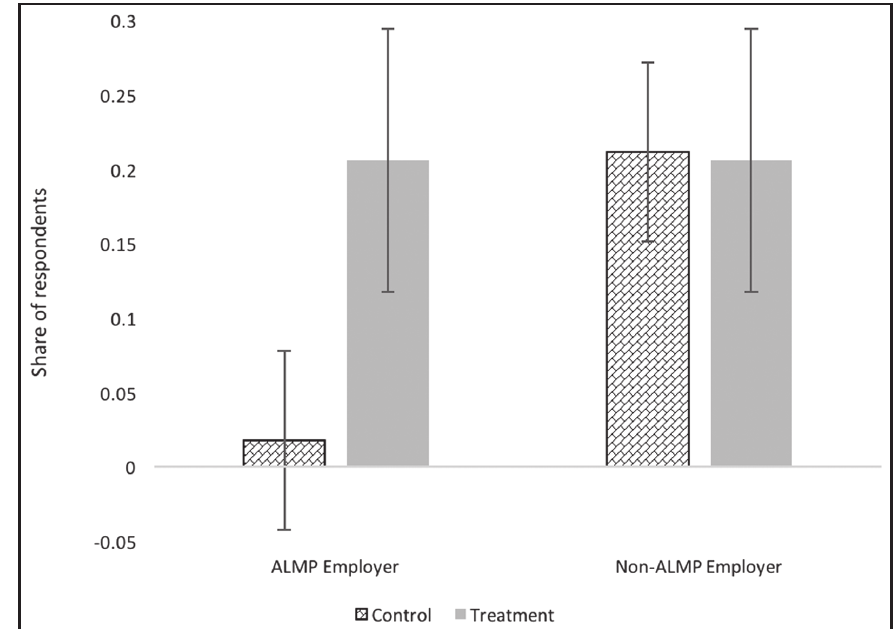
Impact of the program on formal employment by type of